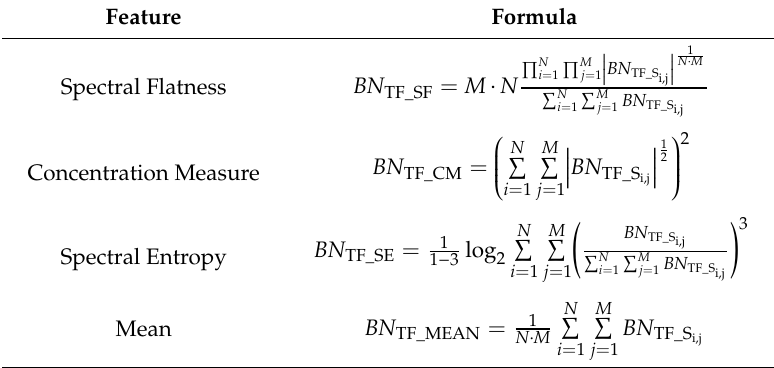
Table 1. Definition of selected features based on spectrogram BN TF_S of TF representation S BN ( t , f